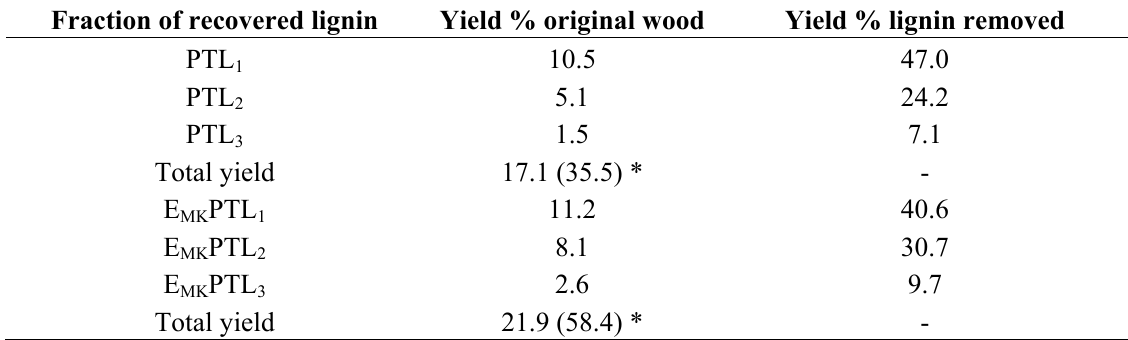
Table 4. Lignin and lignin degradation products recovered from the spent liquor of AWO delignification of PT and E PT. MK